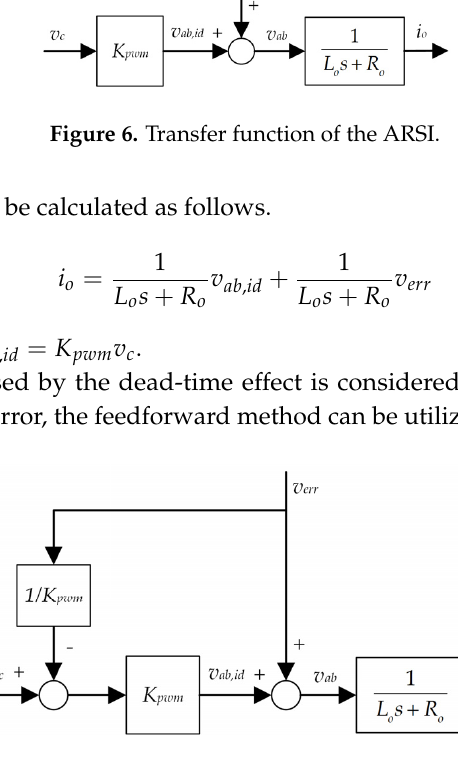
Figure 7. Transfer function of the ARSI with feedforward compensation.